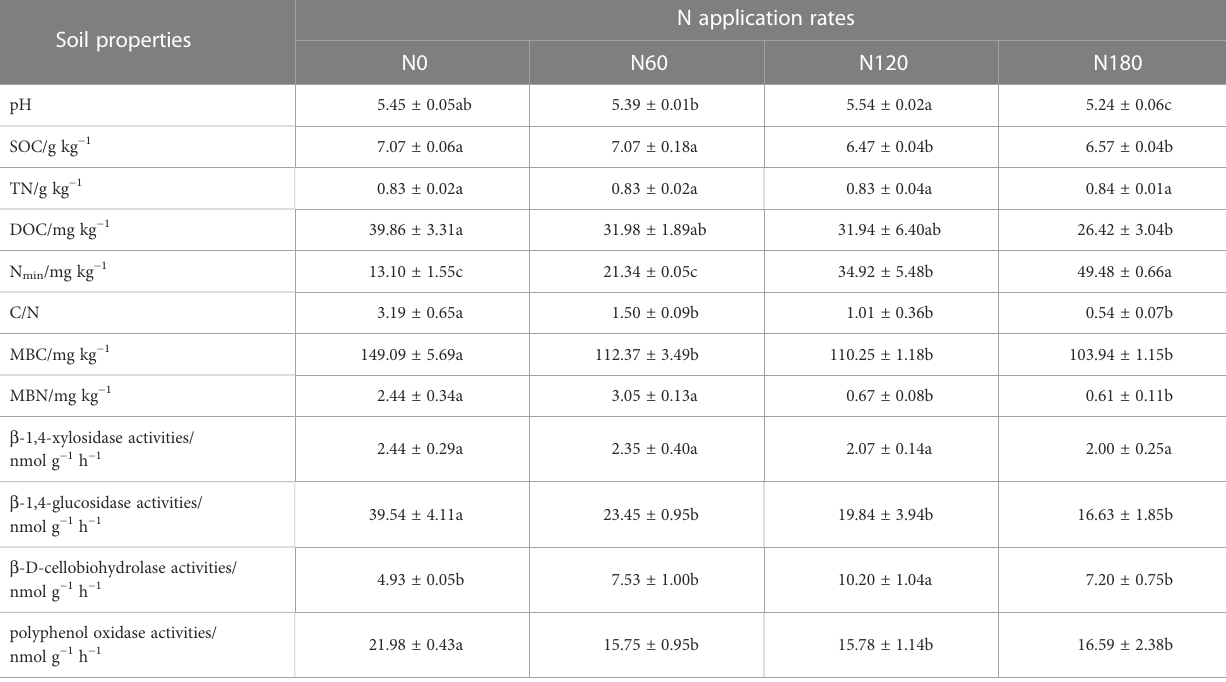
TABLE 1 Soil properties affecting the rhizosphere soil microbial communities sampled in August 2021.